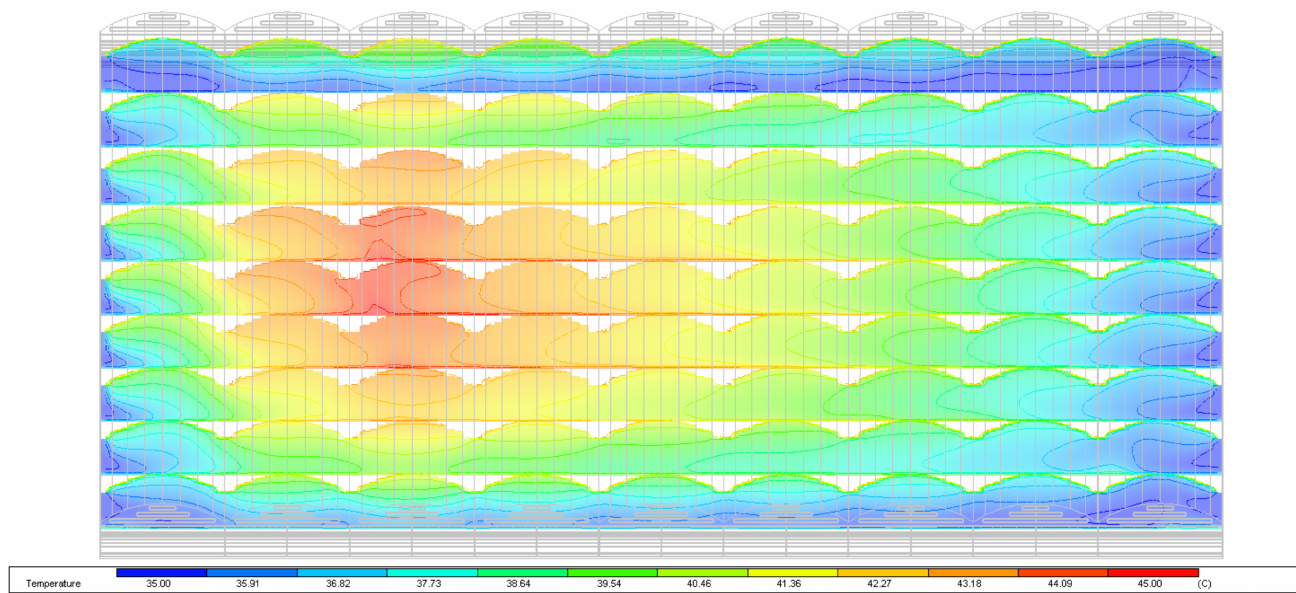
Figure 13. Temperature cloud map of the multi-span round-arch greenhouse (without an in- greenhouse ventilation channel) (outdoor wind speed 0 m/s, outdoor temperature 35 ◦